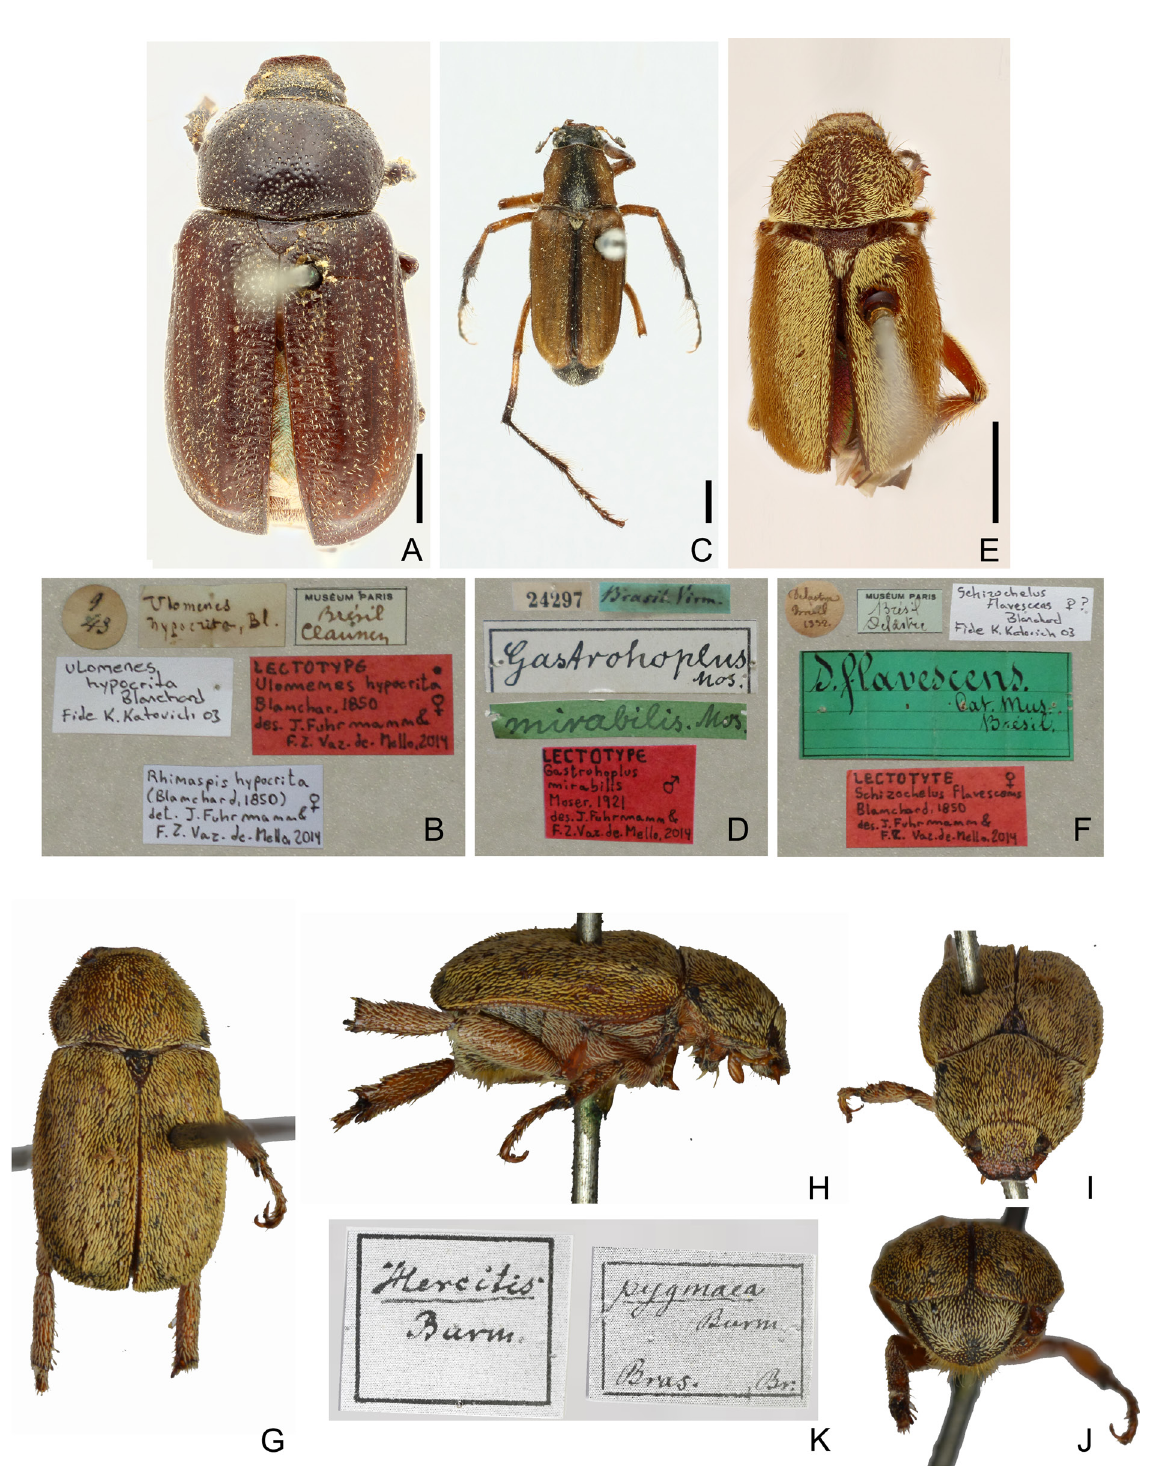
Fig 21. Primary types. A–F . Lectotypes (dorsal, labels). A–B . Ulomenes hypocrita